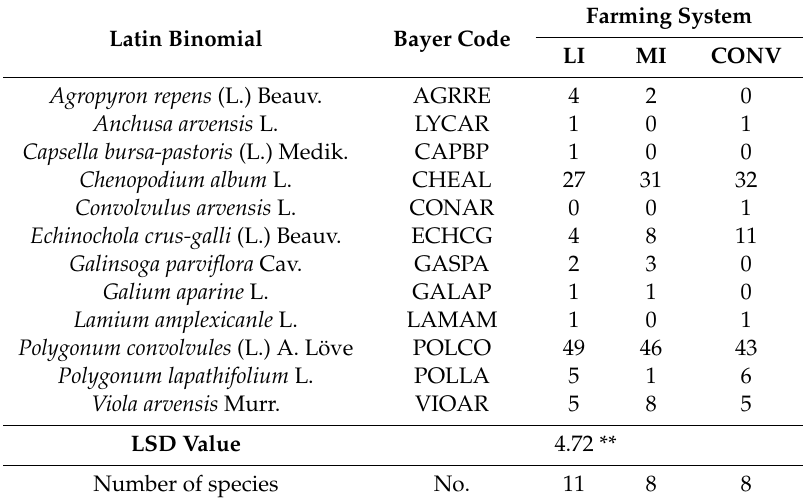
Table 4. E ff ect of farming system and cultivar type on level of weed infestation, yield, and seed protein content. Farming System Specification LSD Value LI MI CONV Dry weight of weeds (g)